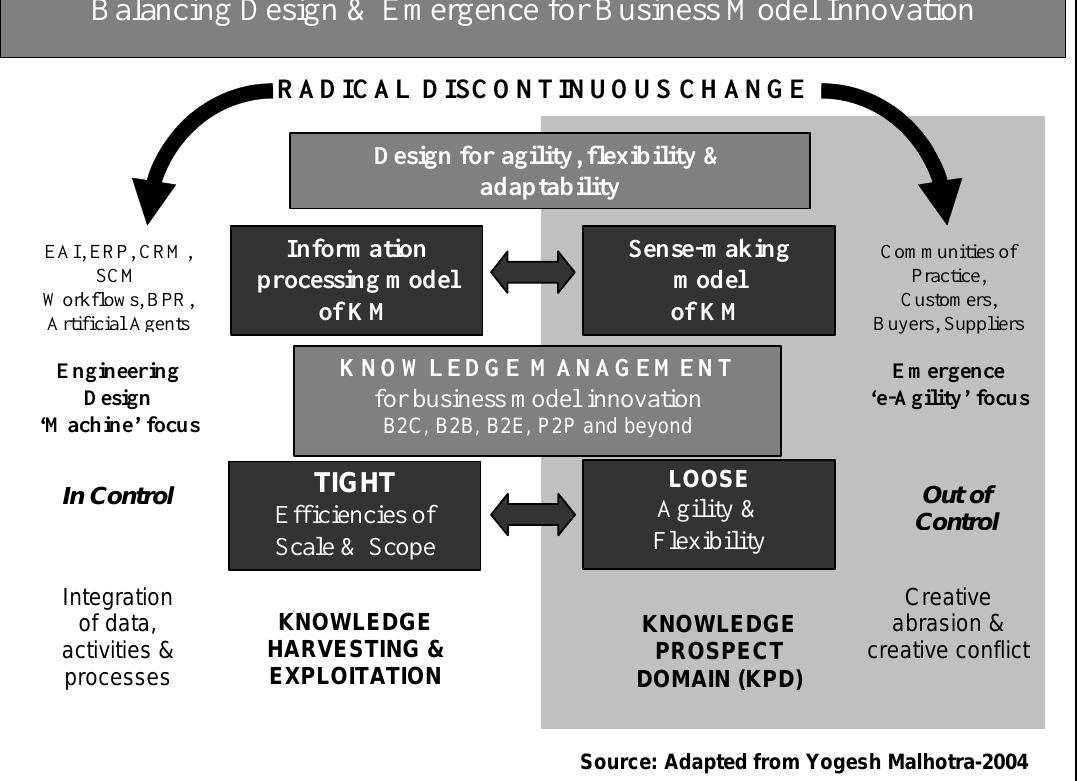
Figure 1 Knowledge Prospect Domain (KPD) identified in Malhotra